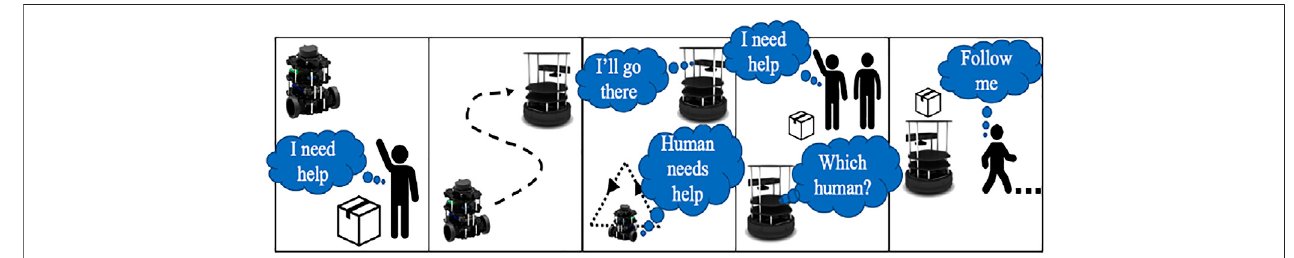
FIGURE 6 | Operational task fl ow.